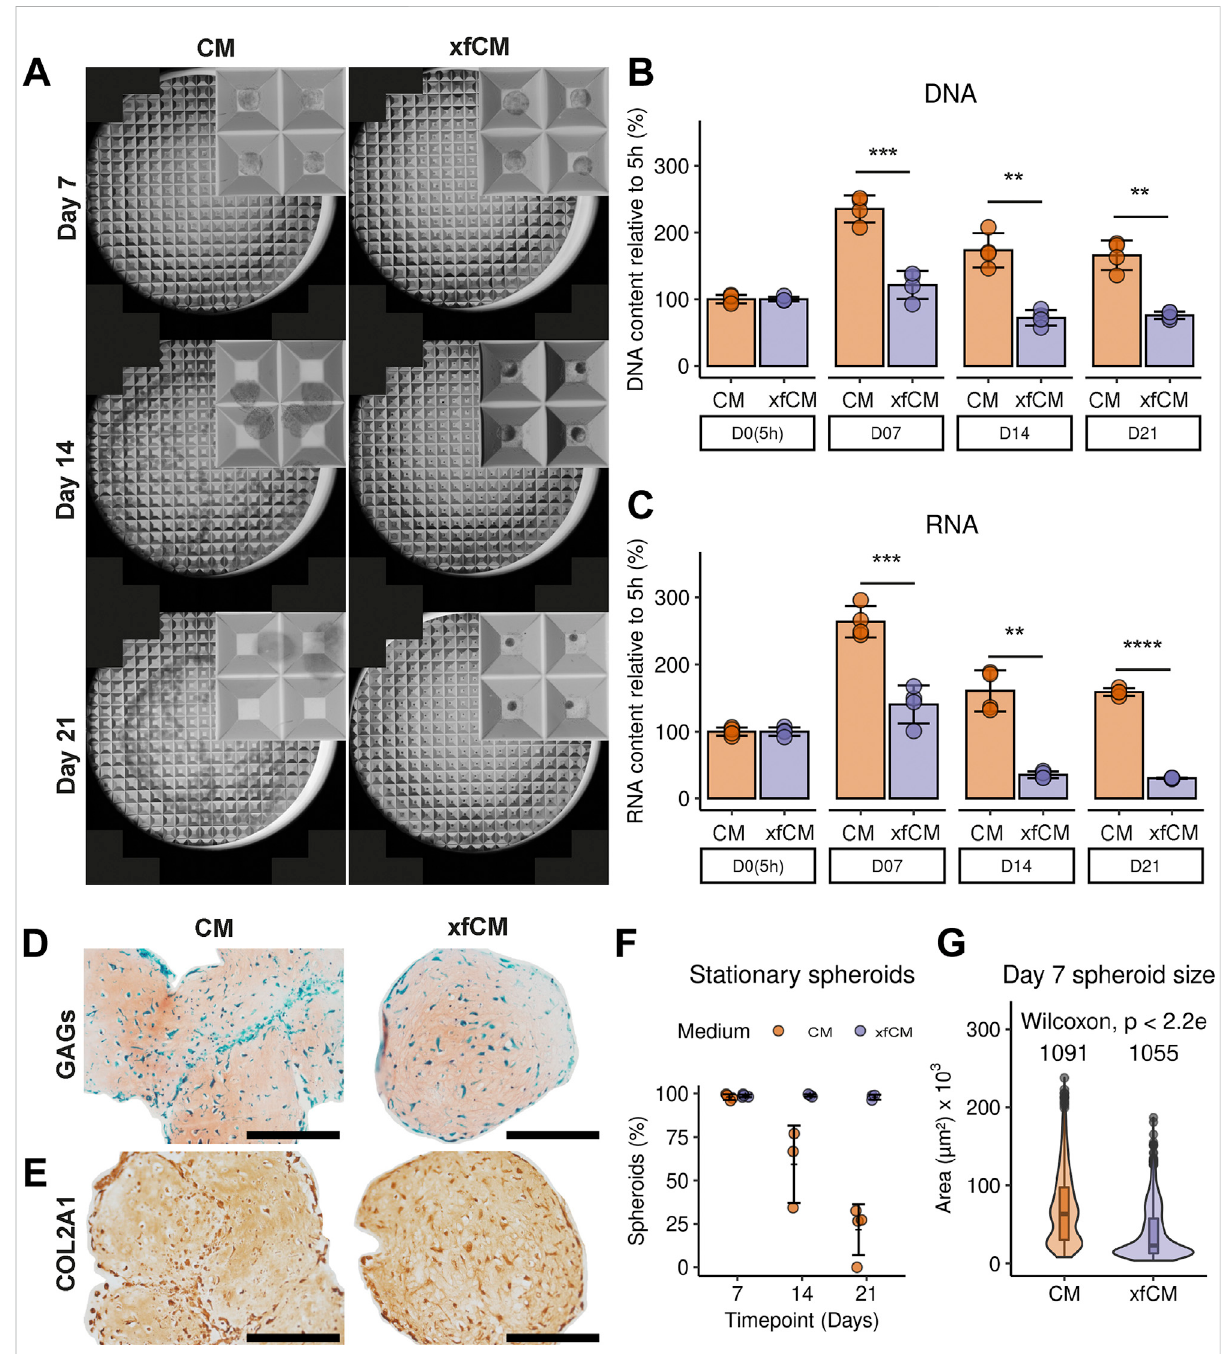
FIGURE 1 Microtissue culture in CM versus xfCM. (A) Bright- fi eld microscopy full-well and detail images of microtissues on day 7, 14, and 21. Each microwell is 800 µM. (B,C) DNA and RNA content of one well, containing approximately 300 microwells, normalized to 5 h. (D) GAG deposition in day 21 microtissues determined by SafO/FG/H staining. (E) Collagen type 2 deposition in day 21 microtissues. (F) Percentage of microtissues that remainedintheirmicrowellsovertime. (G) Sizedistributionofmicrotissuesonday7.Dataispresentedasmean±standarddeviation.Scalebar= 200